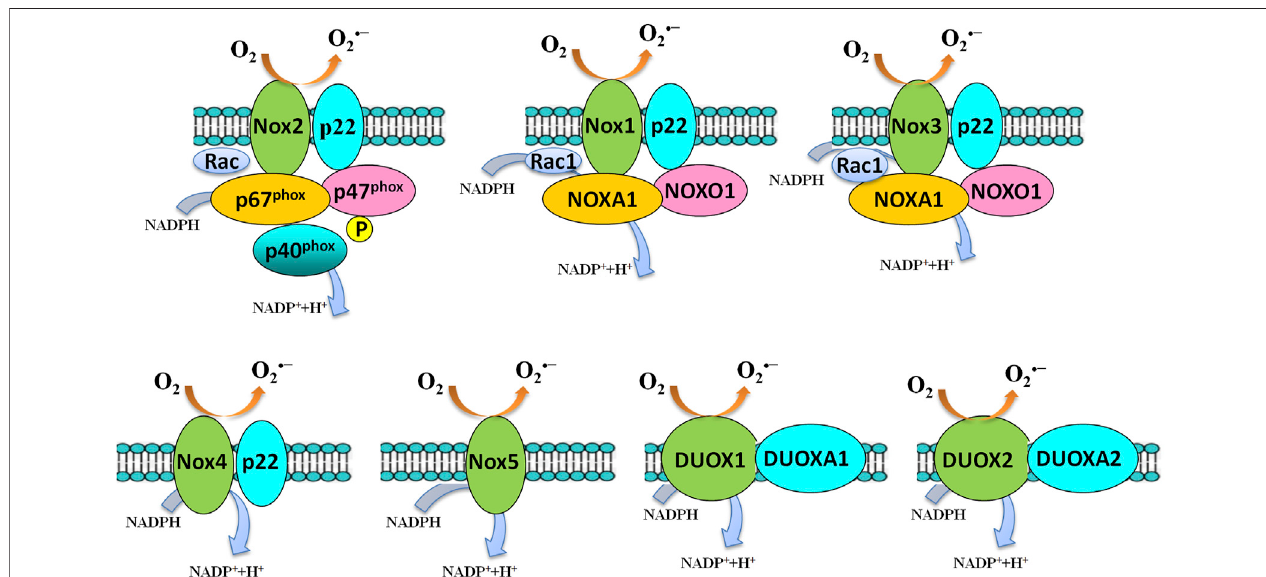
FIGURE 4 | Activation of the NADPH oxidase family members. Several components and domains make up the transmembrane-active enzyme complexes of NADPH oxidase isoforms. NOX1-5 and DUOX1/DUOX2 are shown. Upon activation, an electron will be transferred from NADPH to O 2 to form superoxide. NOX4- generatedsuperoxideundergoesrapidconversionintohydrogenperoxide,whichmediatesmanyofitsdownstreameffects.NOX5andtheDUOXenzymesaresensitive to cellular Ca 2+ concentrations.